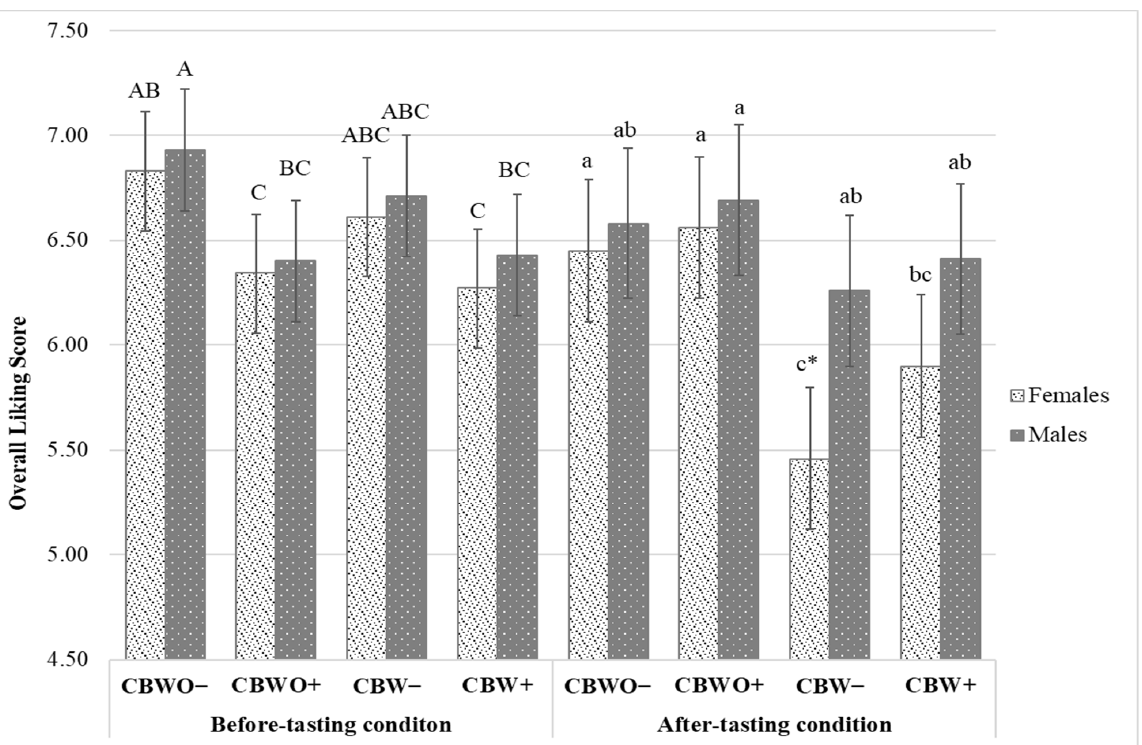
Figure 2. Treatments overall liking (OL) bar chart segmented by tasting condition (before vs. after tasting). Data are OL least square means and standard errors from n = 112 female and n = 98 male groups. Treatments are described in Figure 1. Different uppercase/lowercase letters indicate significantly ( p < 0.05) different before tasting/after tasting OL scores (Tukey’s means separation) across treatments and gender. * Denotes significantly ( p < 0.05) lower after-tasting OL score than its corresponding before-tasting OL score (Tukey’s means separation).